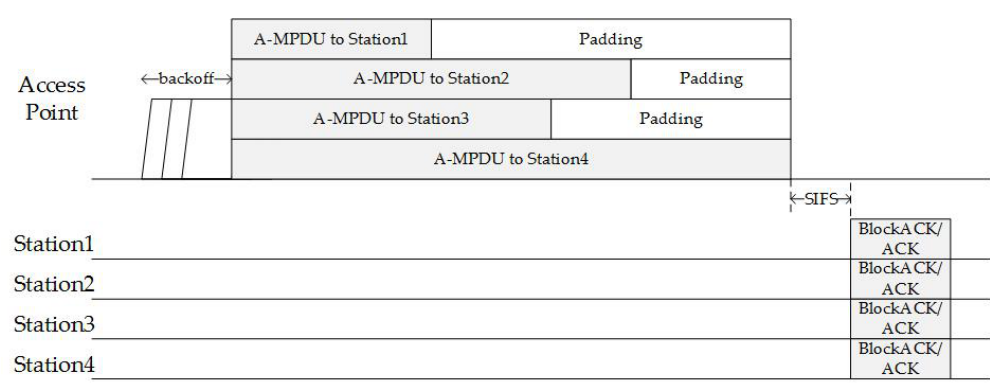
Figure 1. The frame exchange procedure of the downlink (DL) multi-user (MU) transmission in IEEE802.11ax WLANs. A-MPDU (aggregate MAC protocol data unit). BlockACK (block